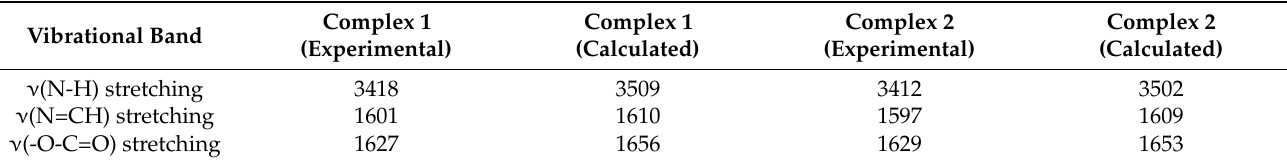
Table 2. Some selected experimental and calculated frequencies (cm − 1 ) of complexes 1 and 2